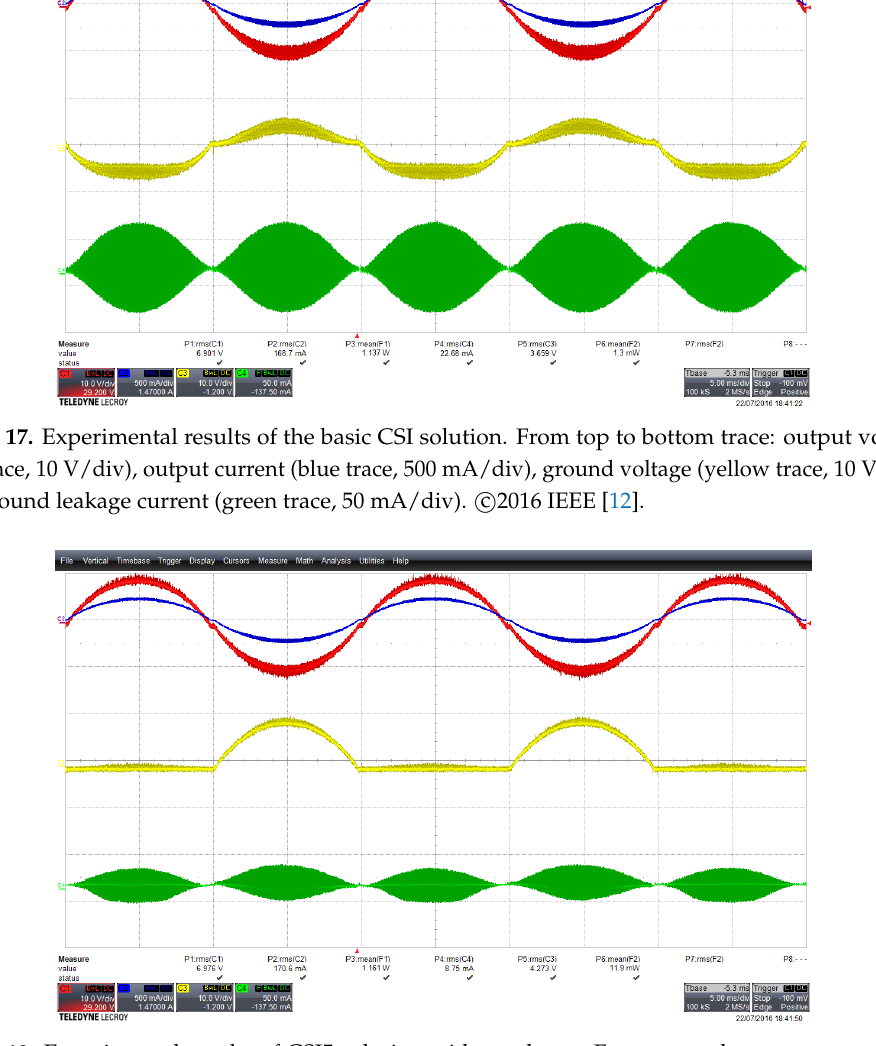
Figure 18. Experimental results of CSI5 solution without clamp. From top to bottom trace: output voltage (red trace, 10 V/div), output current (blue trace, 500 mA/div), ground voltage (yellow trace, 10 V/div), and ground leakage current (green trace, 50